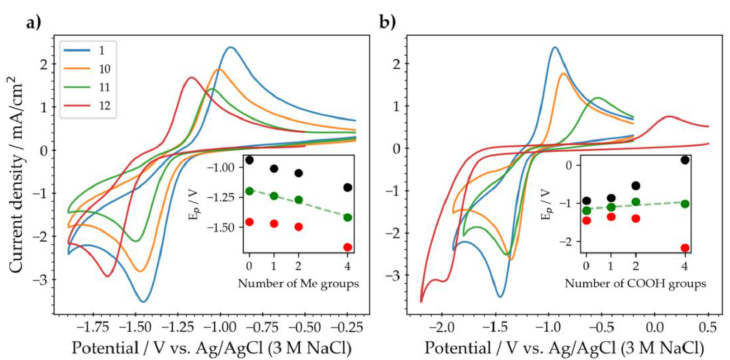
Figure 4. ( a ) Cyclic voltammetry of pyrazine 1 (blue), and mono- 10 (orange), di- 11 (green), and tetra-methyl 12 (red)-substituted pyrazine. ( b ) Cyclic voltammetry of pyrazine 1 (blue) and mono- 13 (orange), di- 14 (green), and tetra-pyrazine-carboxylic acid 15 (red). The black, red, and green circles on the inset graphs correspond to the oxidation, reduction, and average peak potential of each different pyrazine as a function of the number of functional groups. The concentration of each analyte was 5 mM in 0.1 M KOH/0.9 M KCl. The voltammograms were recorded at a scan rate of 250 mV/s using a 3 mm diameter glassy carbon disk